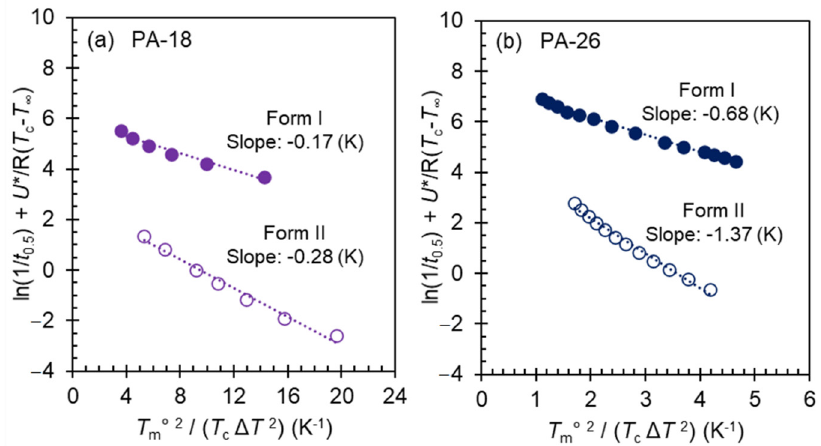
Figure 9. Analysis of the temperature coefficient of the crystallization rate according to classical 3D nucleation theory (Equation (3)) for long-spaced polyacetals PA-18 ( a ) and PA-26 ( b ). Closed symbols are Form I and open symbols are Form II.